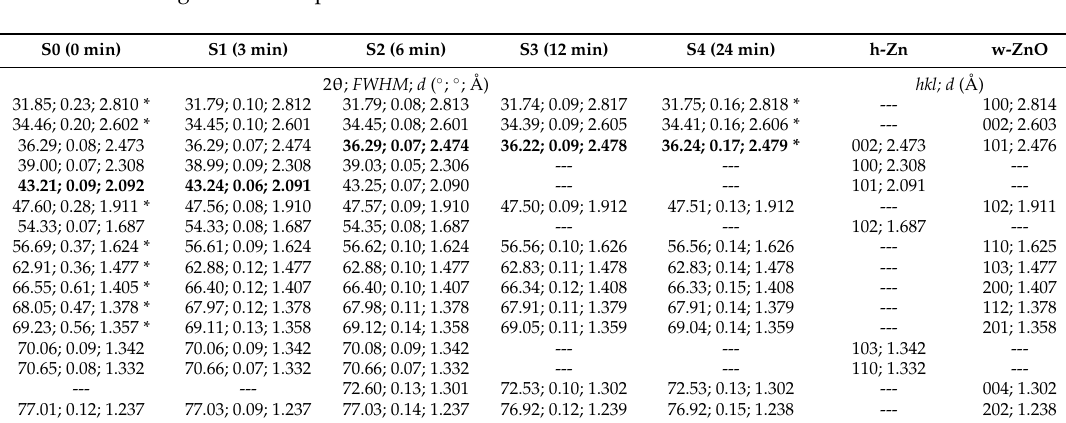
Table 1. Diffraction angle (2 θ ), calculated interplanar distance ( d ), and full width at high maximum (FWHM) of the X-ray peaks observed in the diffractograms of the samples obtained by thermal oxidation. The crystallographic data of the h-Zn (JCPDS #004–0831) and w-ZnO (JCPDS #036–1451) structures are given for